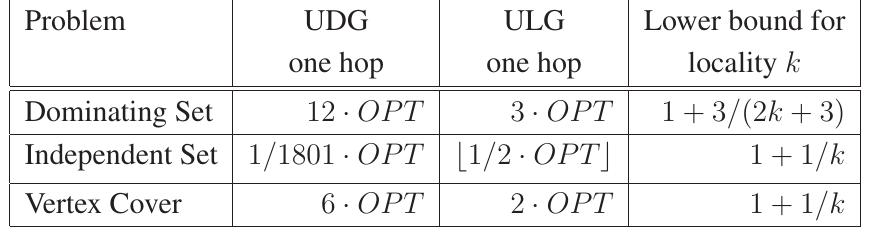
Table 1 . Results for low localities presented in this paper. Note that the bound for dominating set depends on the congruence class of k . The bound given in this table represents the worst case.